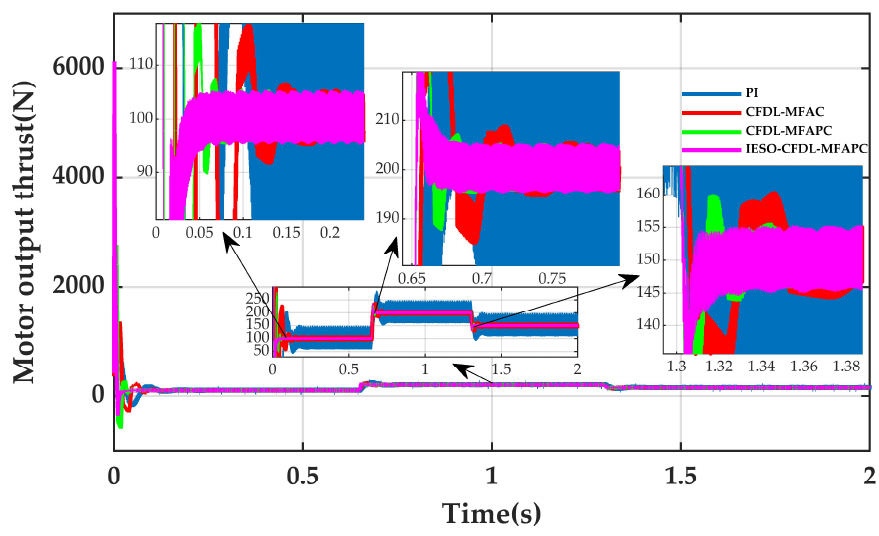
Figure 8. Load variation curve.